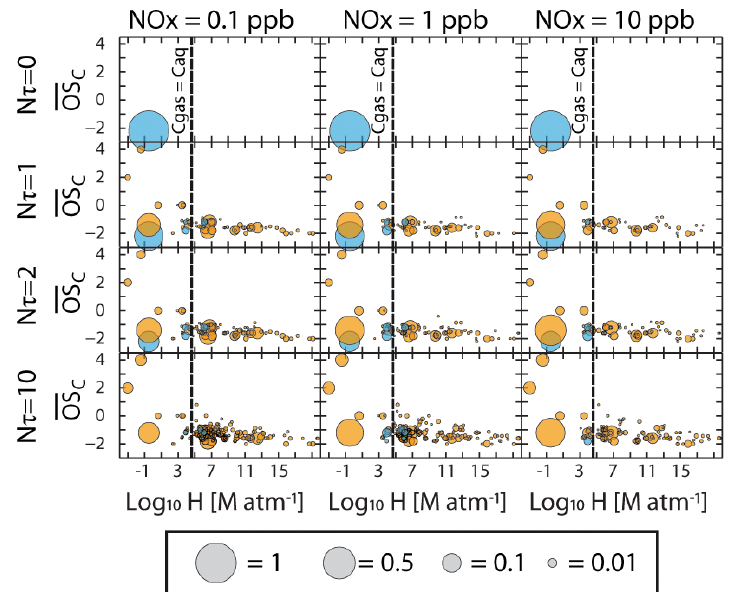
Fig. 8. Solubility and mean oxidation state of the species produced during the oxidation of α -pinene under low NO x (1st column), interme- diate NO x (2nd column) and high NO x (3rd column) conditions as a function of the number of precursor lifetime. See Fig. 6 caption for the color code of the